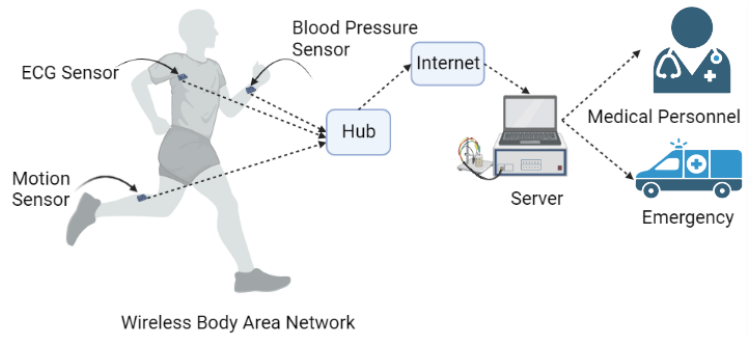
Figure 14. General structure of